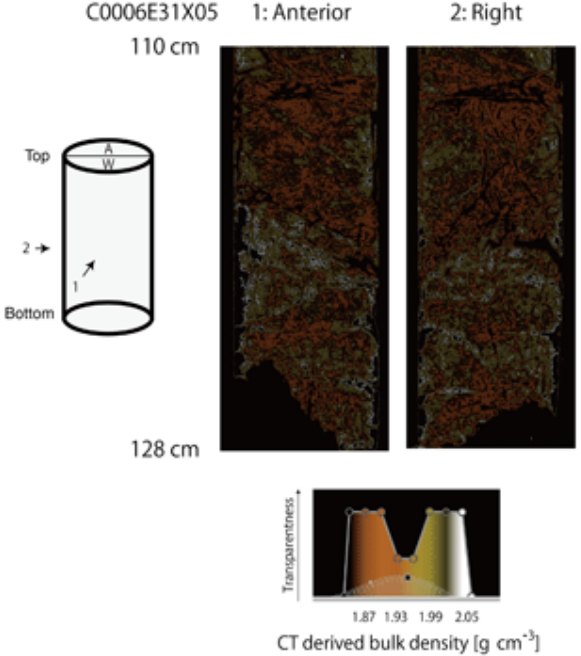
Figure 6. Bulk density distributions converted from the CT value for section C0006E31X05 110–128cm. Two cross sections through the centre of the core are presented. A 3-D distribution of this sec- tion is presented as a movie in the